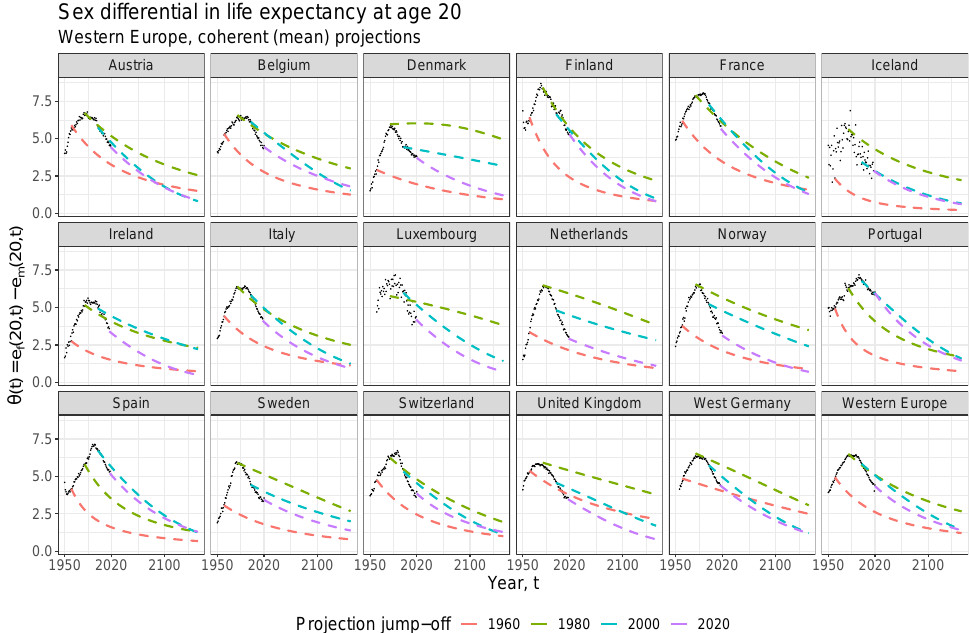
Figure 5. Forecast of the life expectancy sex gap in Western Europe using a dynamic Gompertz model with parameters forecasted as a random walk with drift, cf. Equation (21), and varying jump-off